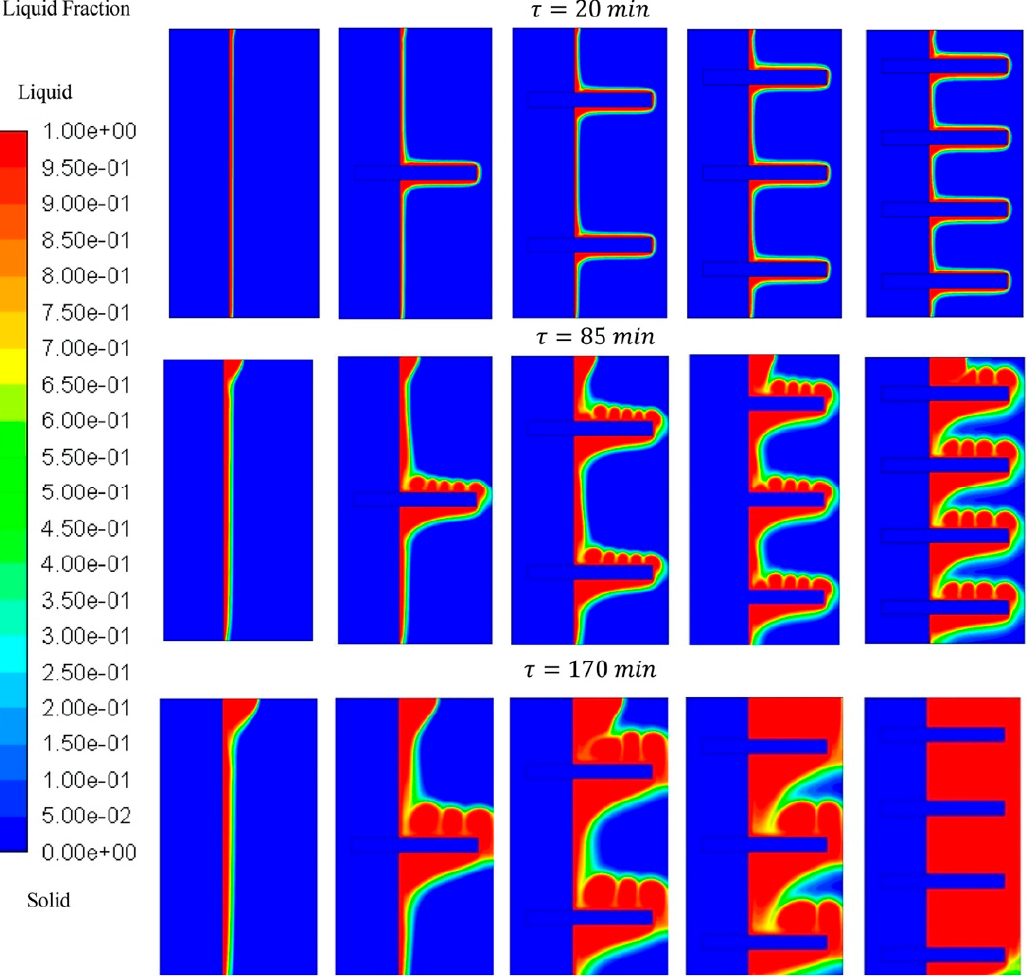
Figure 13. The PCM liquid fractions at three different times with the different numbers of heat pipes. (Copyright 2019 Elsevier) [82].